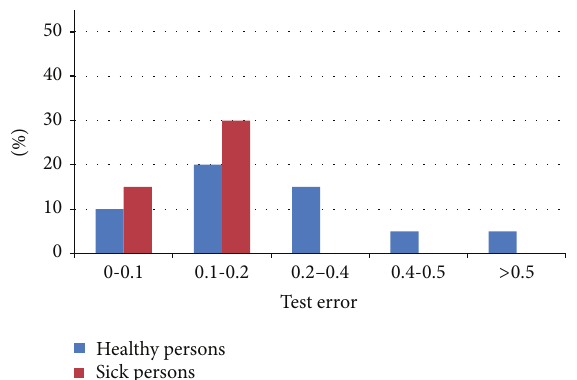
Figure 5: Experimental results, test error for healthy/sick persons.